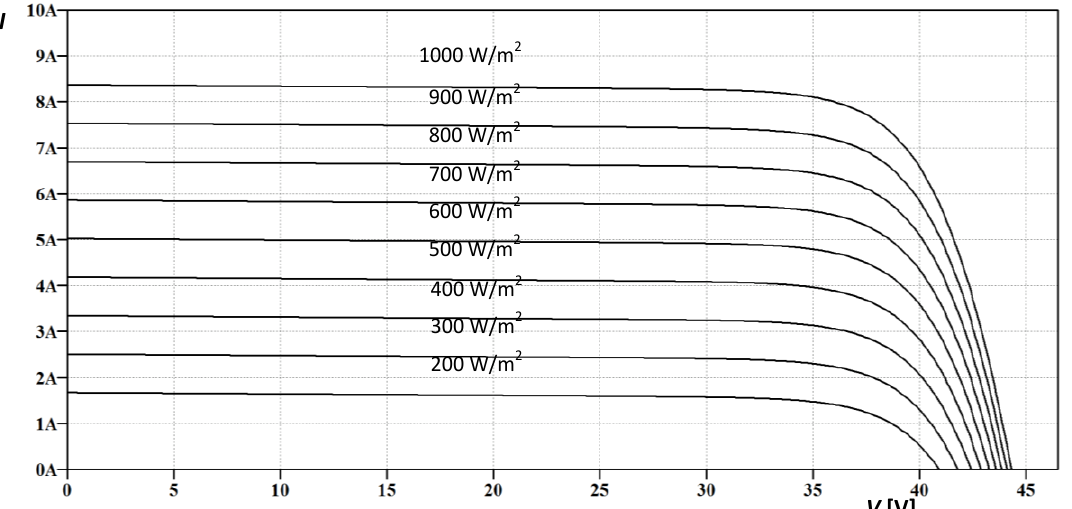
Figure 6. I-V curves of panel MSP290AS-36.EU simulated with LTSpice calculation of the equivalent circuits for different irradiation levels, from 200 W/m 2 to 1000 W/m 2 , at 25